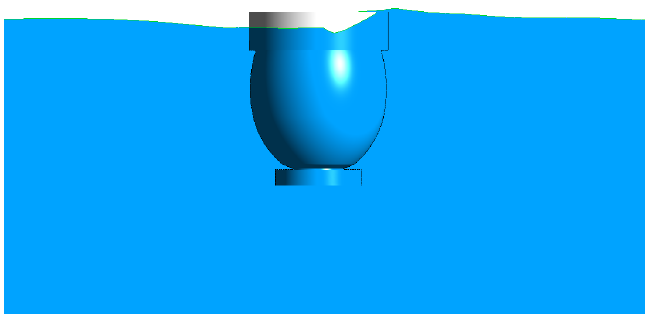
Figure 13. CFD results on the symmetry plane for Re = 7.8 × 10 5 : water fraction.